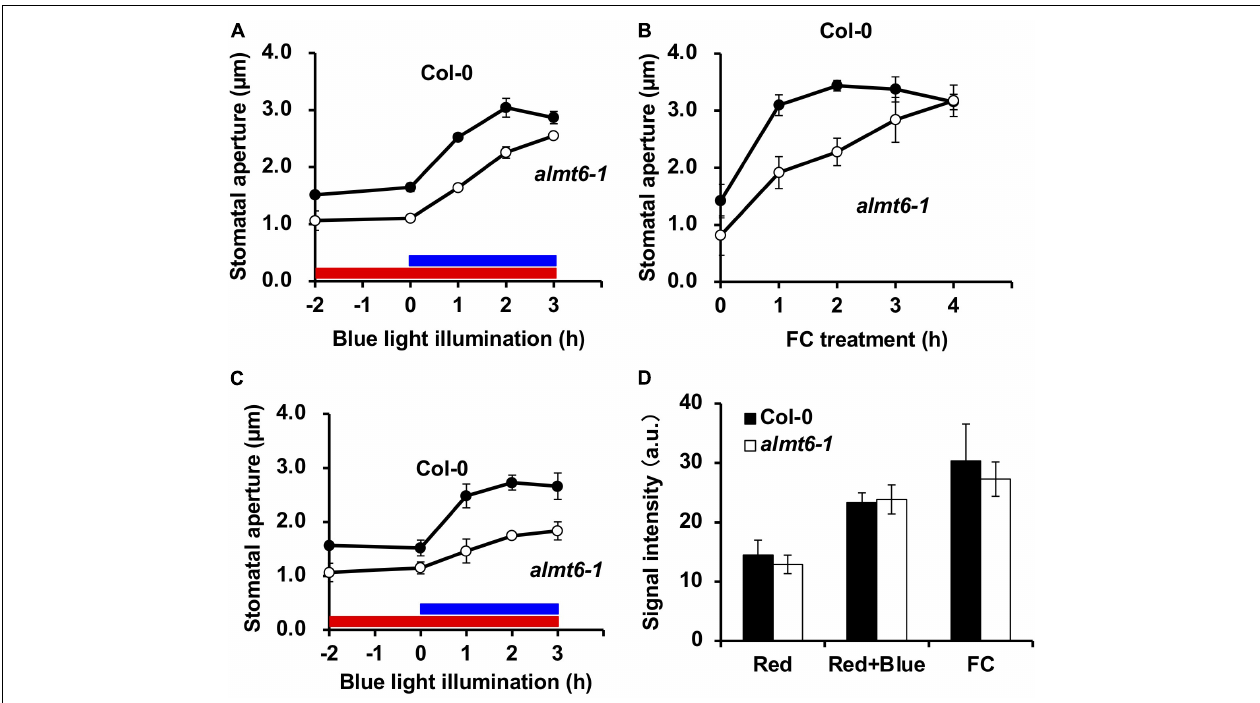
FIGURE 4 | Stomatal phenotypes in wild-type Col-0 and almt6-1 mutant. (A) BL-induced stomatal opening in wild-type Col-0 and almt6-1 mutant epidermal tissues. Red bar: RL illumination period (50 µ mol m − 2 s − 1 ). Blue bar: BL illumination period (10 µ mol m − 2 s − 1 ). (B) Fusicoccin (FC)-induced stomatal opening in Col-0 and almt6-1 epidermal tissues. In panels (A,B) , epidermal tissues were incubated in 50 mM KCl, 0.1 mM CaCl 2 , and 10 mM Mes-BTP (pH 6.5) and then subjected to light and 10 µ M FC treatments. (C) BL-induced stomatal opening in low Cl − (0.2 mM) buffer of Col-0 and almt6-1 epidermal tissues. Epidermal tissues were incubated in 50 mM potassium gluconate, 0.1 mM CaCl 2 , and 10 mM Mes-BTP (pH 6.5). Averages from three independent experiments are shown. Error bars: SDs ( n = 3). The other conditions are those in panel (A) . (D) Immunohistochemical detection of BL- and 10 µ M FC-induced phosphorylation of PM H + -ATPase in Col-0 and almt6-1 GCs. GC fluorescence was quantified using an anti-pThr antibody and Alexa Fluor 488-conjugated secondary antibody as described in section “Materials and Methods.” Bars: Averages from three independent experiments. Error bars: SDs ( n = 3). a.u., arbitrary